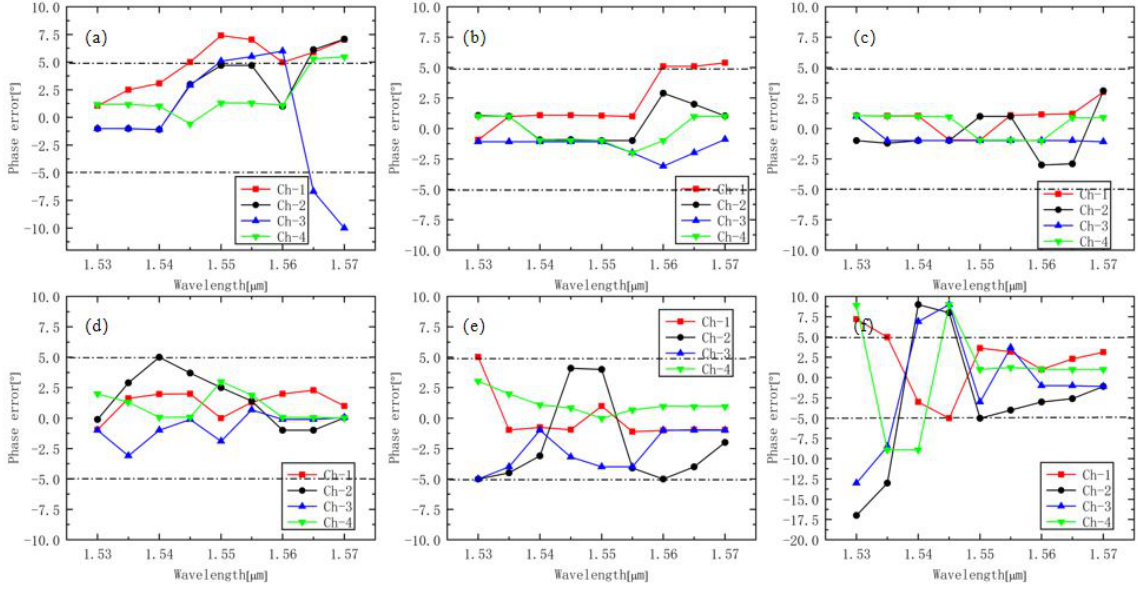
Figure 6. Simulated PEs of the hybrid with different widths of ( a ) 19.7 μm, ( b ) 19.8 μm, ( c ) 19.9 μm, ( d ) 20.1 μm, ( e ) 20.2 μm, and ( f ) 20.3 μm across the C-band.